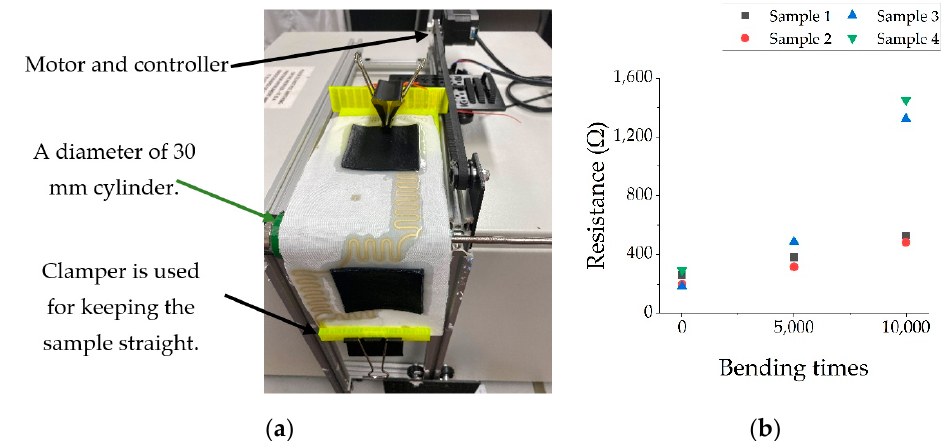
Figure 5. ( a ) Bending test set-up; ( b ) the change of electrode resistance during bending